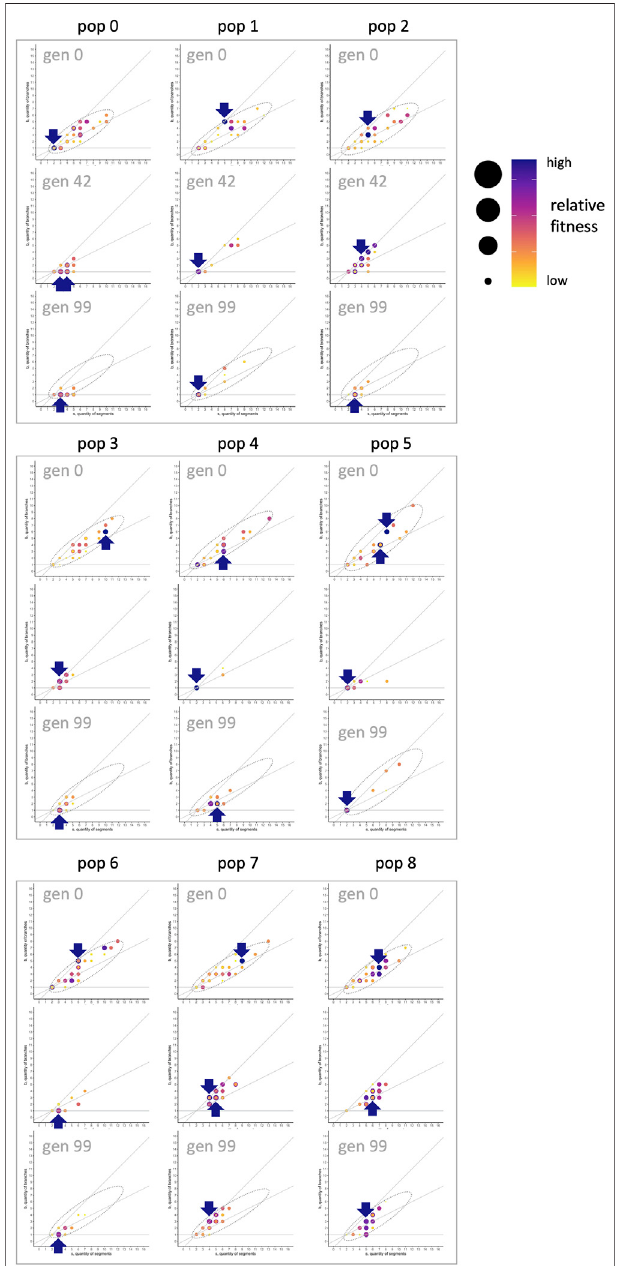
FIGURE14| Morphospaceandtheshifting fi tnesslandscape.Tocreate fi tness landscapes in the s − b morphospace, the relative fi tness of the 60 individuals in a population is encoded by color ( μ fi xed at 0.0025). In each of ninepopulations, theindividualwiththehighestrelative fi tness(redpoint, red arrow) represents an adaptive peak at three different generations (0, 42, 99). Over generational time, note the shift in the fi tness peak, showing that the adaptive landscape is in fl